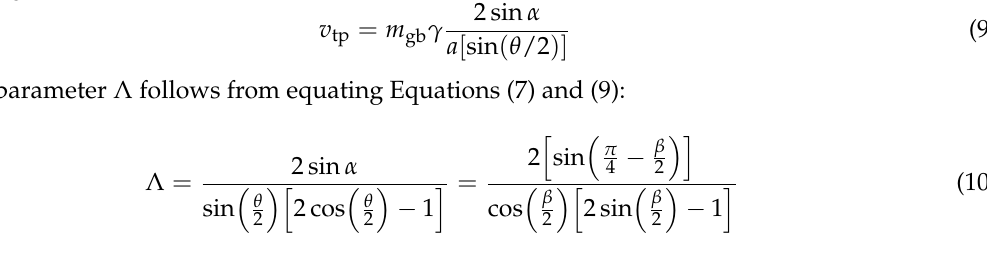
and the grain boundary velocity is proportional to the curvature κ 1